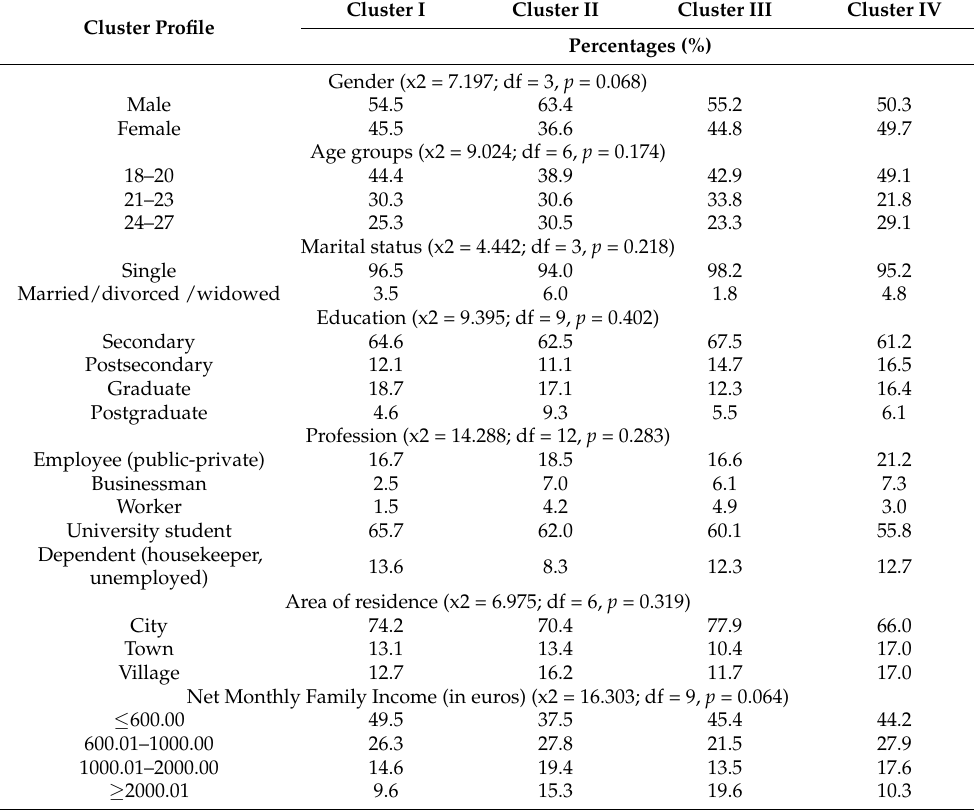
Table 6. Profile of University students’ Generation Z cohort